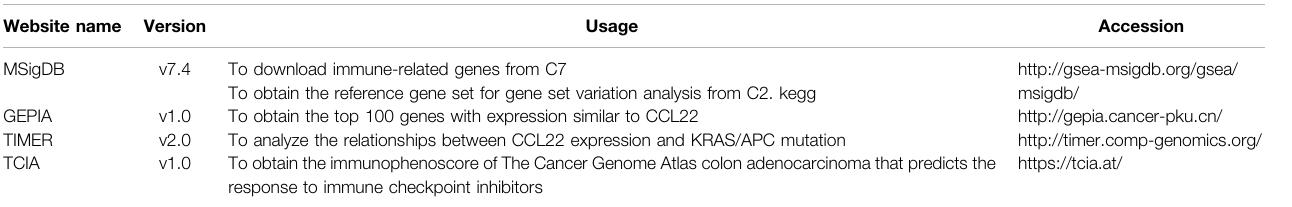
TABLE 2 | Detailed information of the online websites used in our